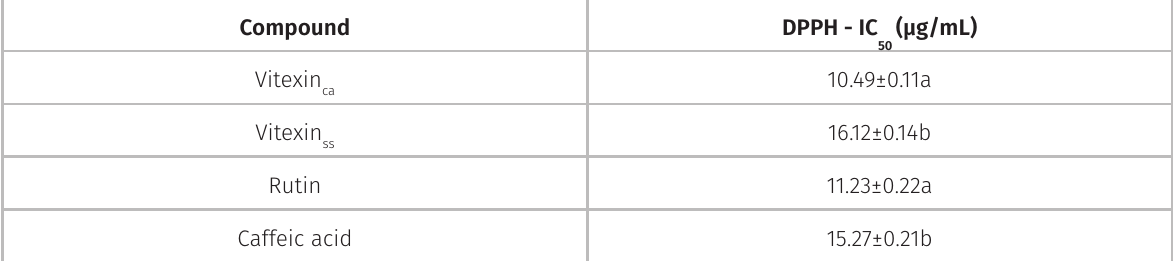
Table V. DPPH radical scavenging activity of vitexin isolated from C. antisyphiliticus (Vitexin vitexin (Vitexin ) and positive control (Rutin and Caffeic ss